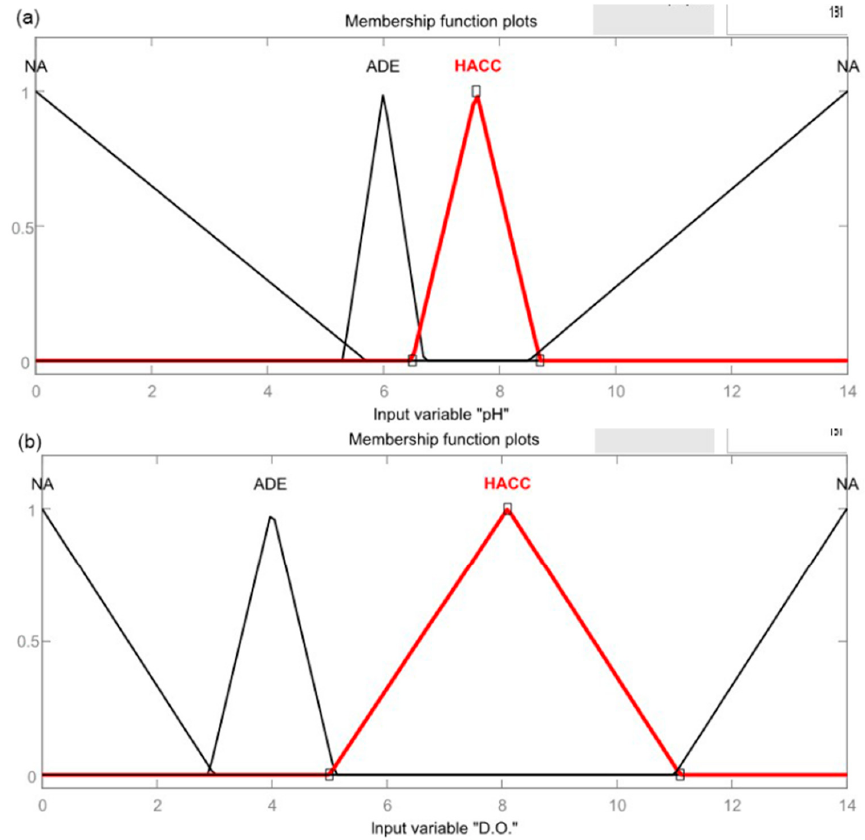
Figure 8. Membership function (MF) plots based on fuzzy rule for water quality parameters ( a ) pH and ( b ) DO [63].